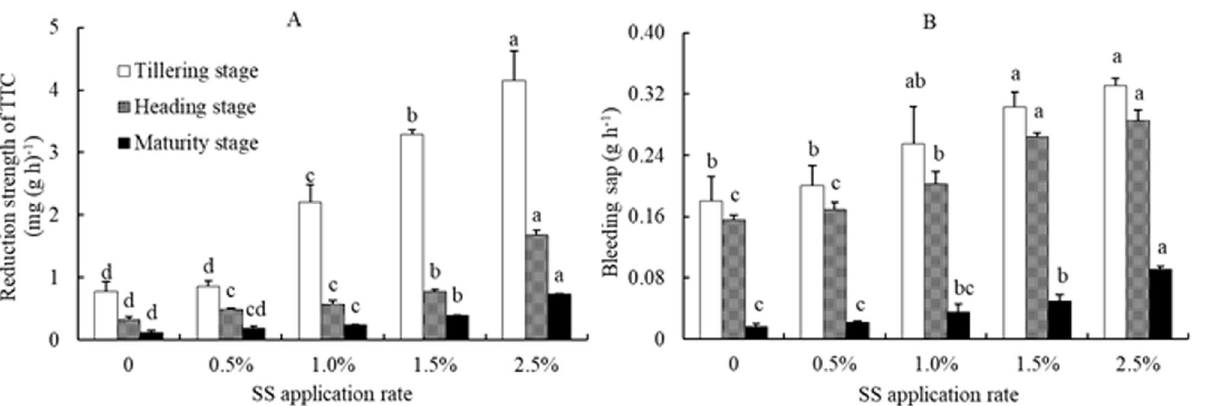
Figure 3. Effects of sewage sludge (SS) application on root activity ( A ) and bleeding sap ( B ) of rice plant in salt-affected mudflat soil. Columns with different letters show significant difference between SS application rates at p < 0.05 by LSD’s multiple range